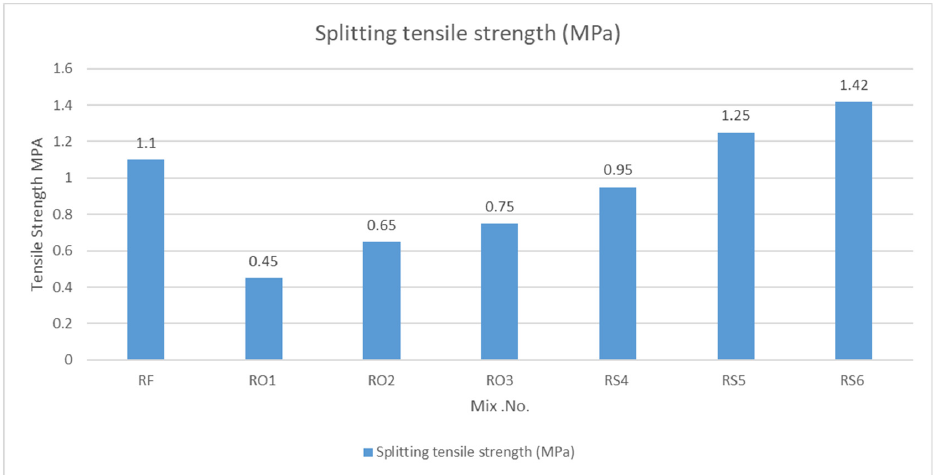
Figure 8. Splitting tensile